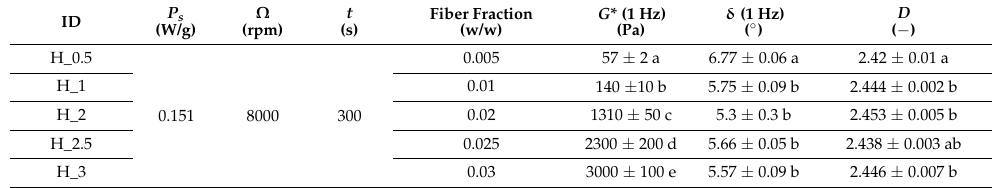
Table 1. Aqueous phases obtained by increasing fiber concentration; mixing conditions fixed at E s = 45.2 J/g and P s = 0.151 W/g. G * is the complex modulus, δ is the phase angle and D is the fractal dimension (Equation (10)). Different letters, for the same parameter, refer to significantly different